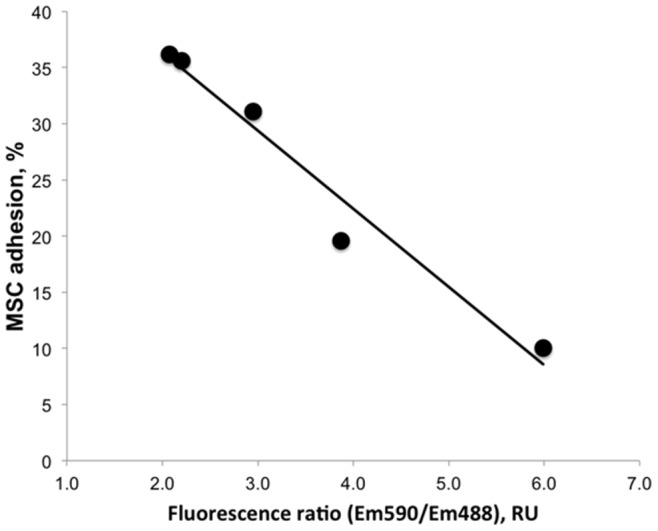
Correlation of MSC adhesion to HUVECs with the inhibition of mitochondrial transmembrane potential of ECs.Data from Figures 2B and 3A were used to estimate Pearson’s correlation between the MSC adhesion and the inhibition of mitochondrial transmembrane potential of HUVECs. MSC adhesion showed a strong correlation (R = 0.98, P-value = 0.003) with the inhibition of mitochondrial transmembrane potential of ECs.